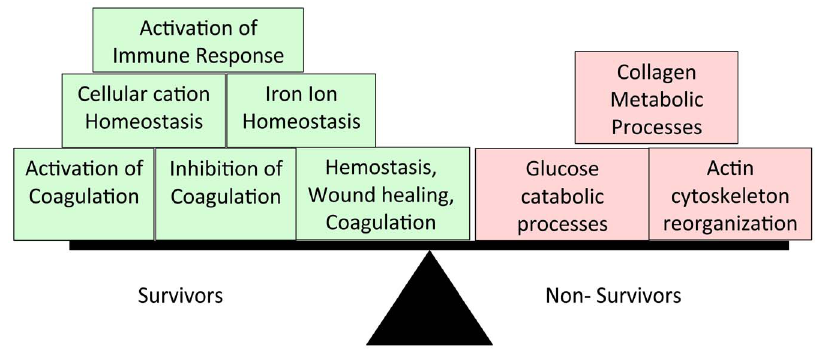
Figure 1. Biological processes represented by 165 proteins that are differentially expressed when early-phase non-survivors are compared to early-phase survivors. GO enrichment analysis was performed using the universe of identified BALF proteins as a background. A Functional Annotation Clustering tool was used to group related biological processes. Annotation clusters with an enrichment score . 1.3 are shown. In the functional annotation-clustering tool, an enrichment score of 1.3 that corresponds to a non-log scale p-value of 0.05 was used as the cutoff for significance.